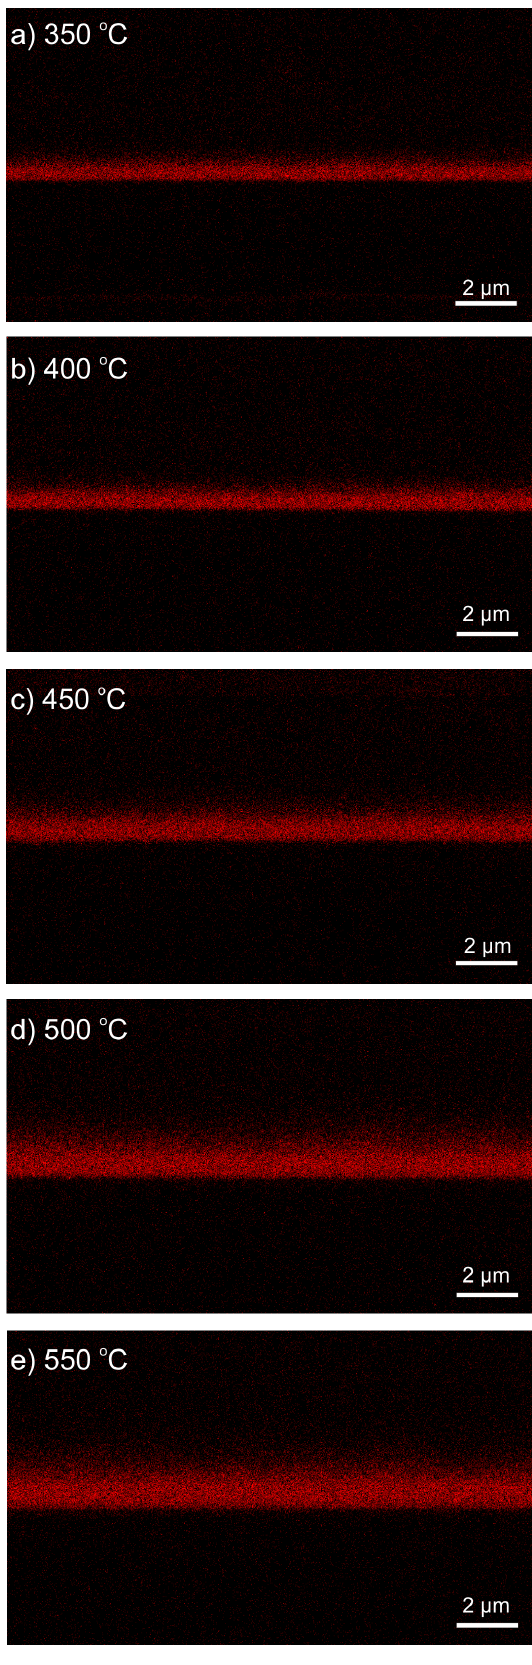
Figure 7. The EDX analysis on the Sn diffusion for samples sintered at: a) 350 6 C; b) 400 6 C; c) 450 6 C; d) 500 6 C; e) 550 6 C.